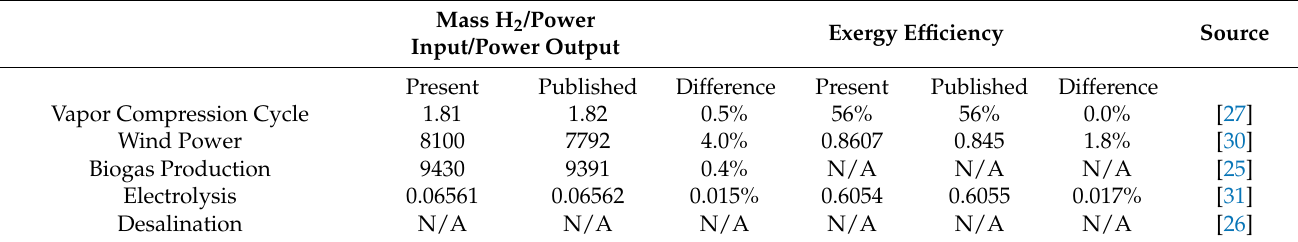
Table 2. Validation table for the results